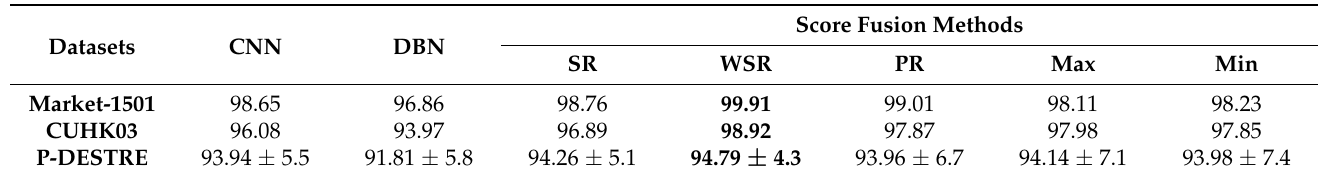
Table 7. Rank-1 identification rate of the developed ReID-DeePNet system on three different ReID datasets using score-level fusion.